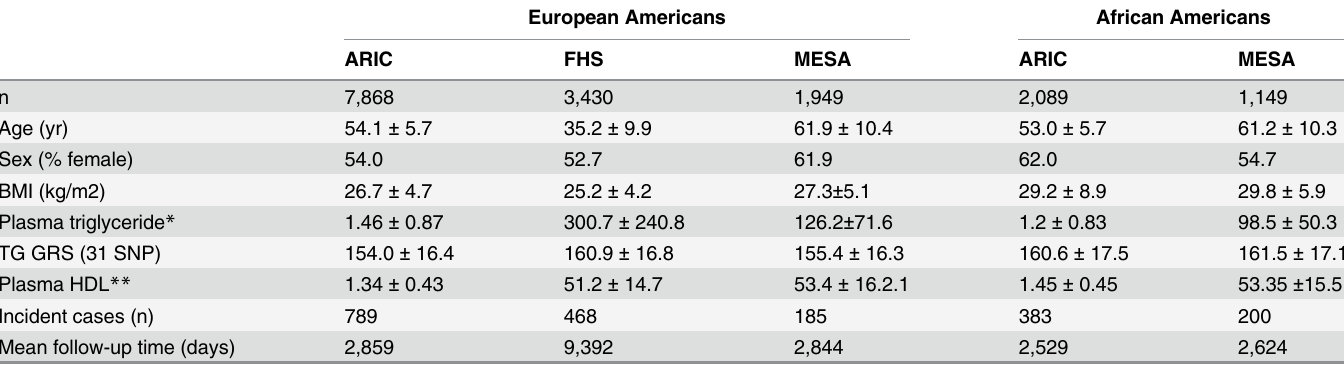
Table 1. Characteristics of the three samples of European-Americans and two samples of